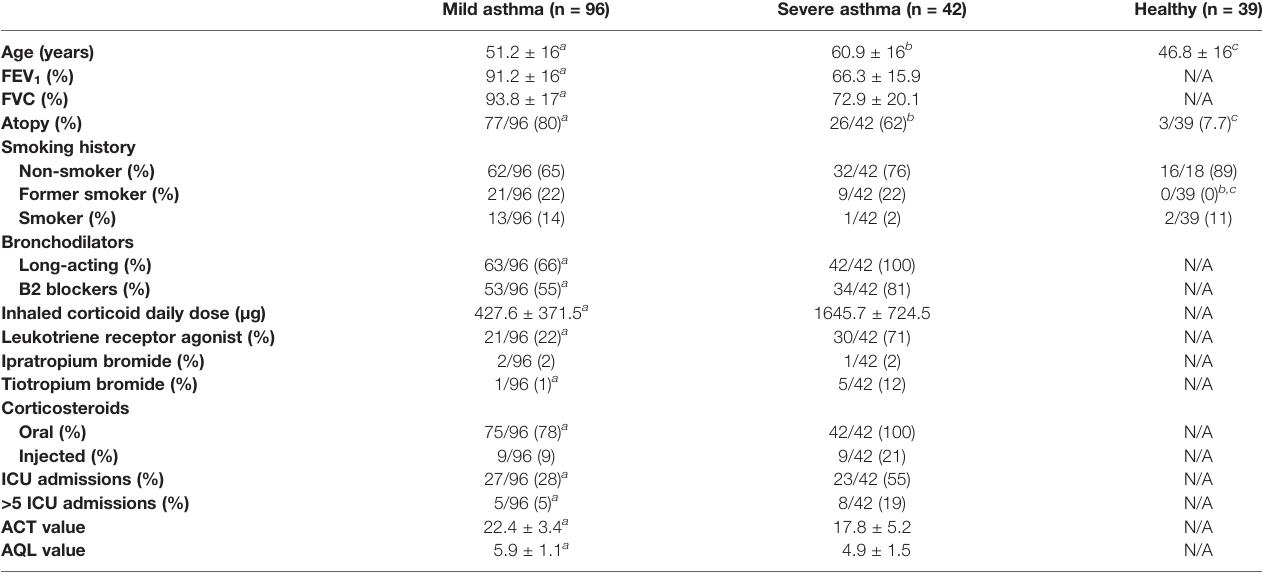
TABLE 2 | Demographic and clinical data of subjects from whom serum was